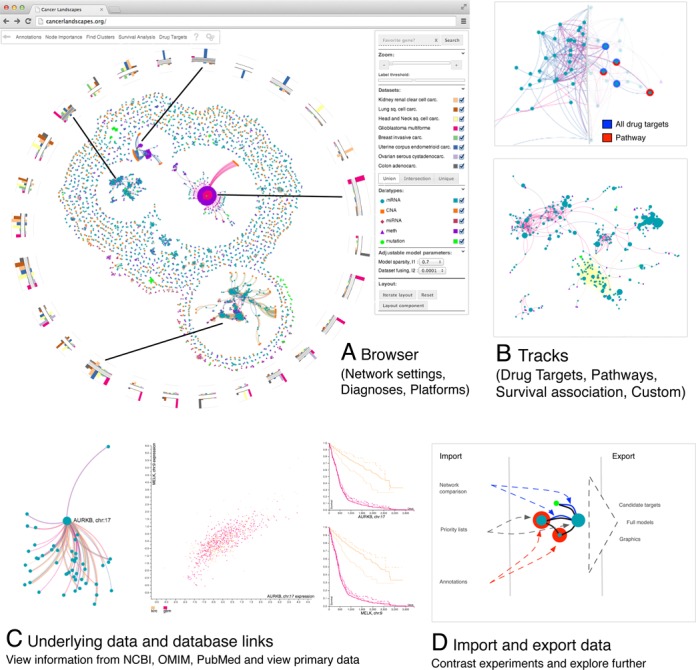
The Cancer Landscapes system is available at cancerlandscapes.org and enables users to access and explore pan-cancer network models built from TCGA data and other sources. The system provides a wide range of functions tailor made for analyzing these models, allowing the user to: (A) View a cluster summary of the network showing regions that contain an overrepresentation of survival biomarkers or pathway annotations. (B) Highlight nodes based on available annotations (PathwayCommons (54), KEGG (55)), GOslim (56) and DrugBank (52,53)) or user supplied lists. (C) Rank nodes according to network centrality measures, survival P-values or user supplied lists, to view the distribution of these rankings across the network. (D) Import node lists or small networks for comparison with the provided models, and exporting the full models or target lists for further analysis in other software.